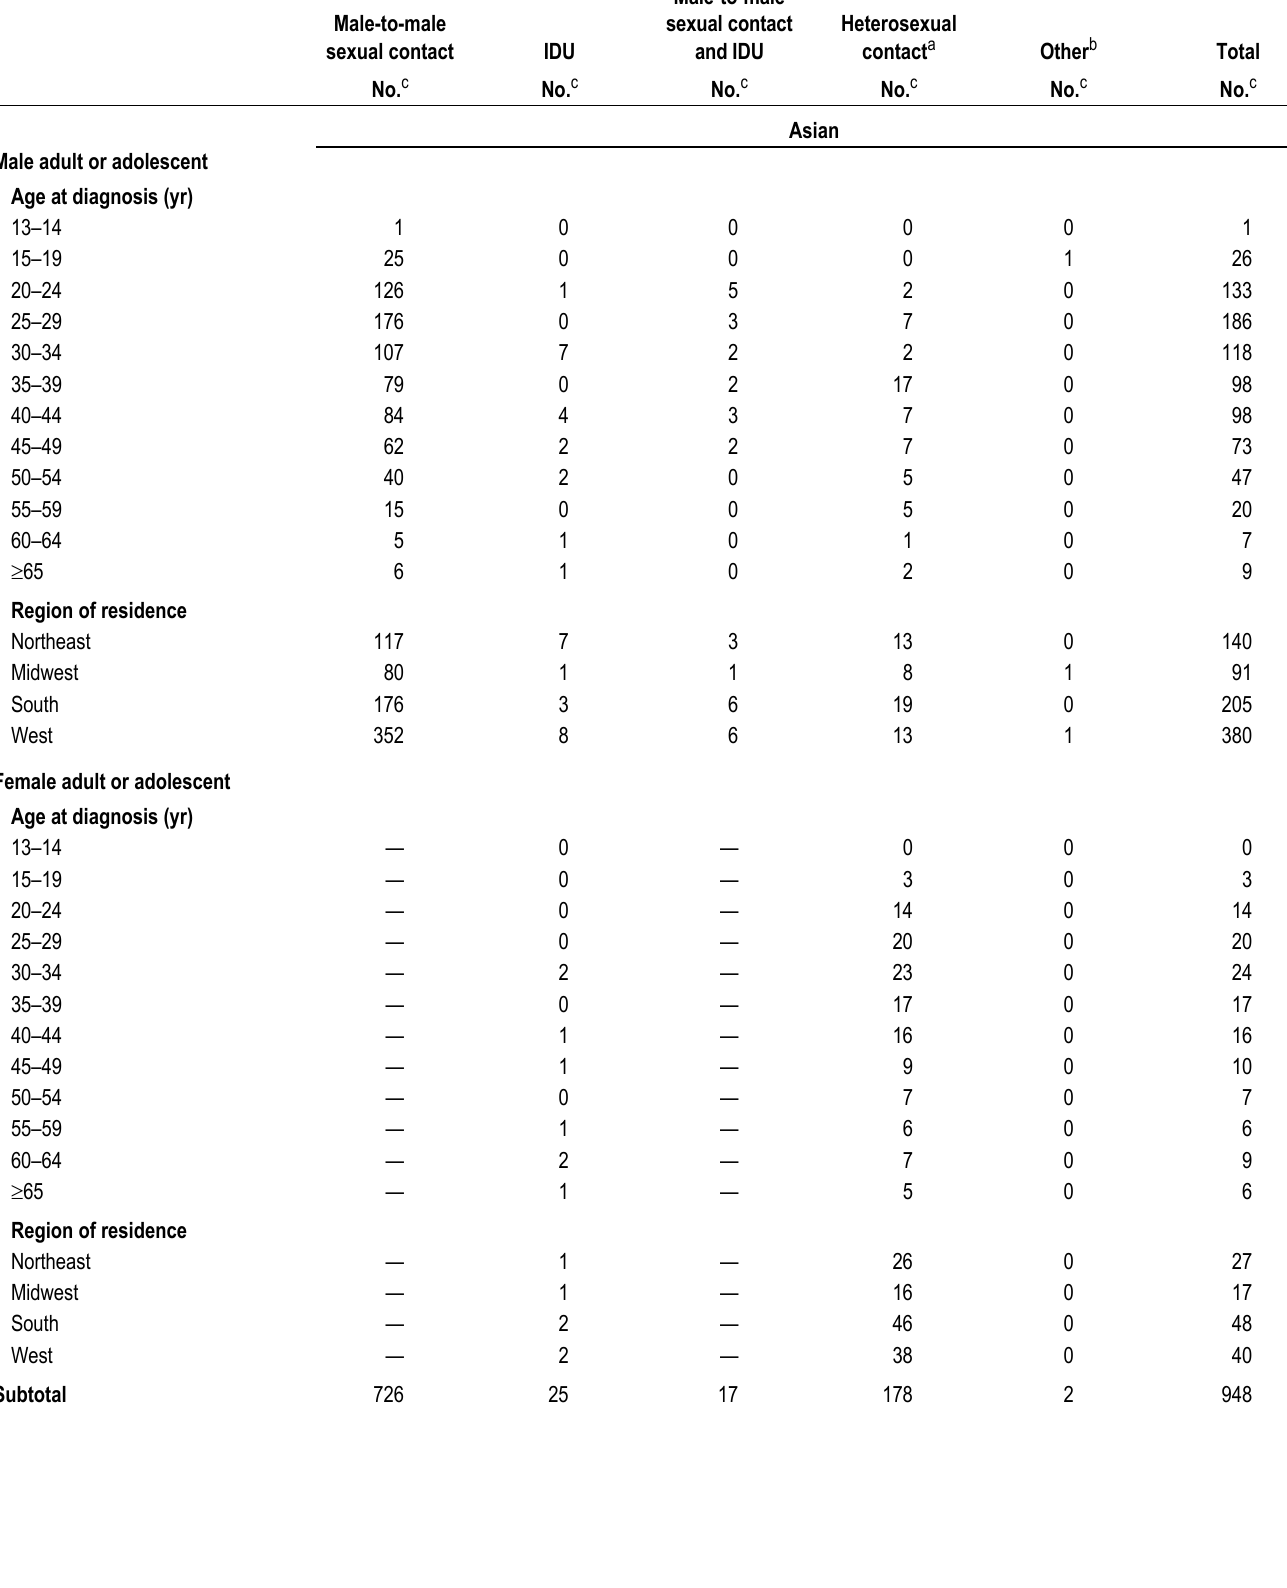
Table 5a. Diagnoses of HIV infection, by transmission category, race/ethnicity, and selected characteristics, 2015—United States